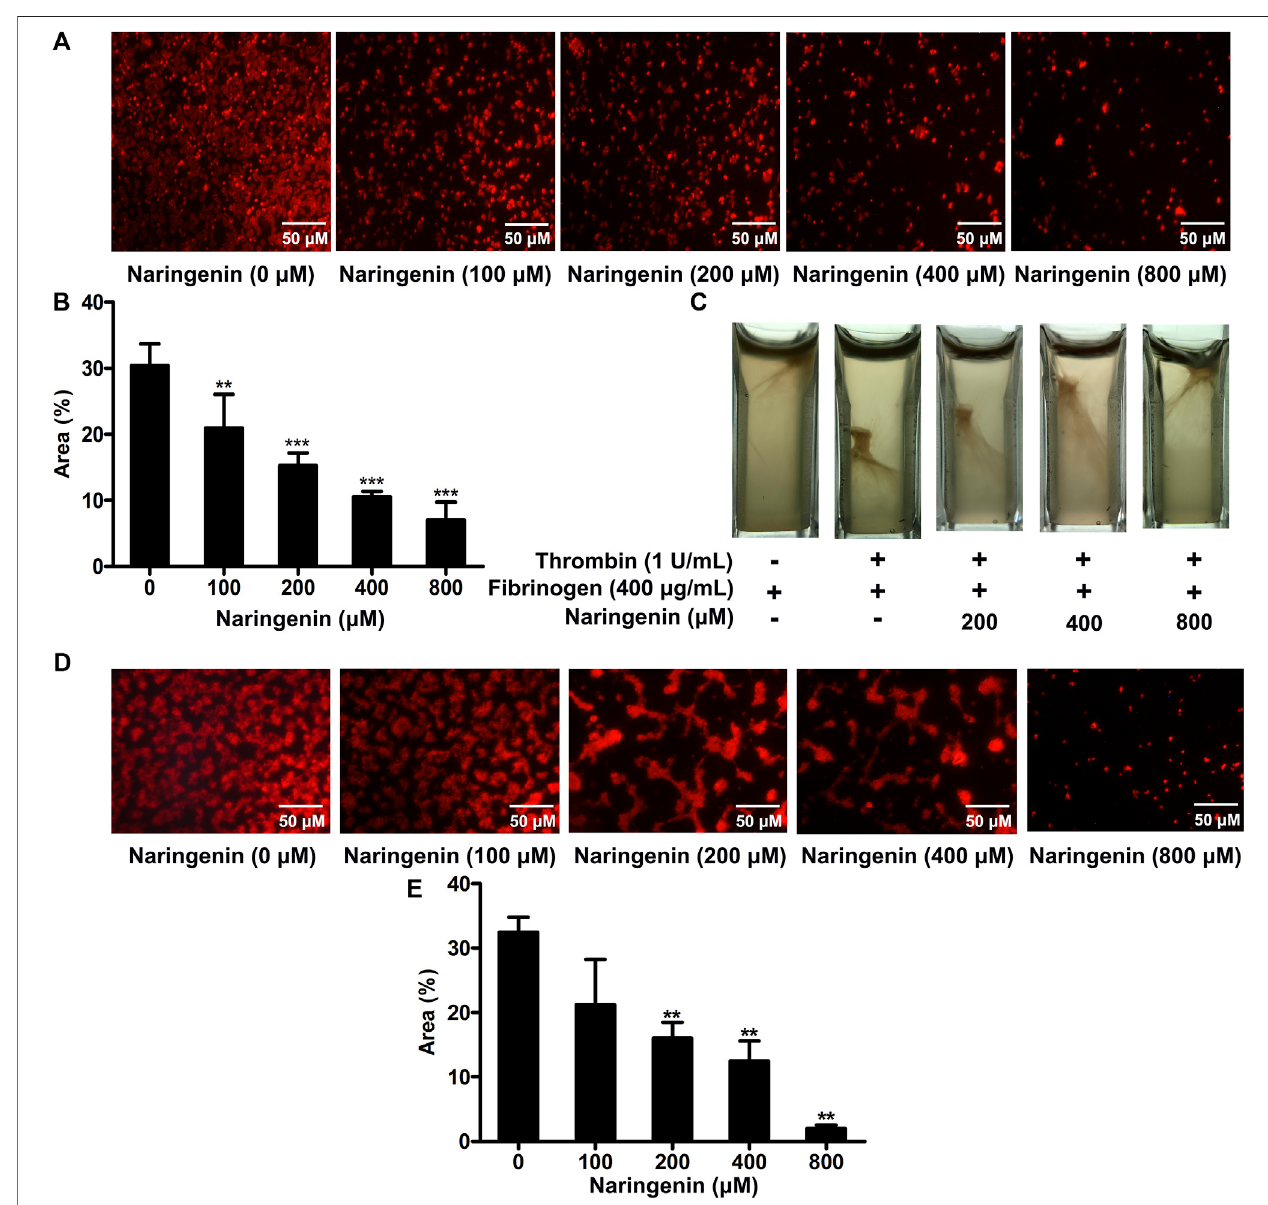
FIGURE 3 | Naringenin inhibits integrin outside-in signaling and platelet adhesion on collagen-coated surfaces. Washed platelets were preincubated with various concentrations of naringenin or vehicle for 10 min at 37 ° C, then allowed to spread on fi brinogen-coated surface. (A) Representative images from one of three independent experiments with similar results. The percentages of the average surface area of individual platelets were plotted (B) . PRP was incubated with naringenin (200, 400 and 800 μ mol/L) or vehicle for 10 min at 37 ° C. Fibrinogen (400 μ g/ml) was added and fi brin clot formation was initiated by the addition of thrombin (1 U/ mL). Photographs of the clots were taken 15 min later. Similar results were obtained in three independent experiments (C) . Washed platelets were preincubated with various concentrations of naringenin or vehicle for 10 min at 37 ° C, then allowed to adhere on collagen-coated coverslips. (D) Representative images from one of three independentexperimentswithsimilarresults.Thepercentagesoftheaveragesurfaceareaofindividualplateletswereplotted (E) .Dataareexpressedasmeans ± SD( n (cid:2) 3). ** p < 0.01, *** p < 0.001 compared with the vehicle control group.